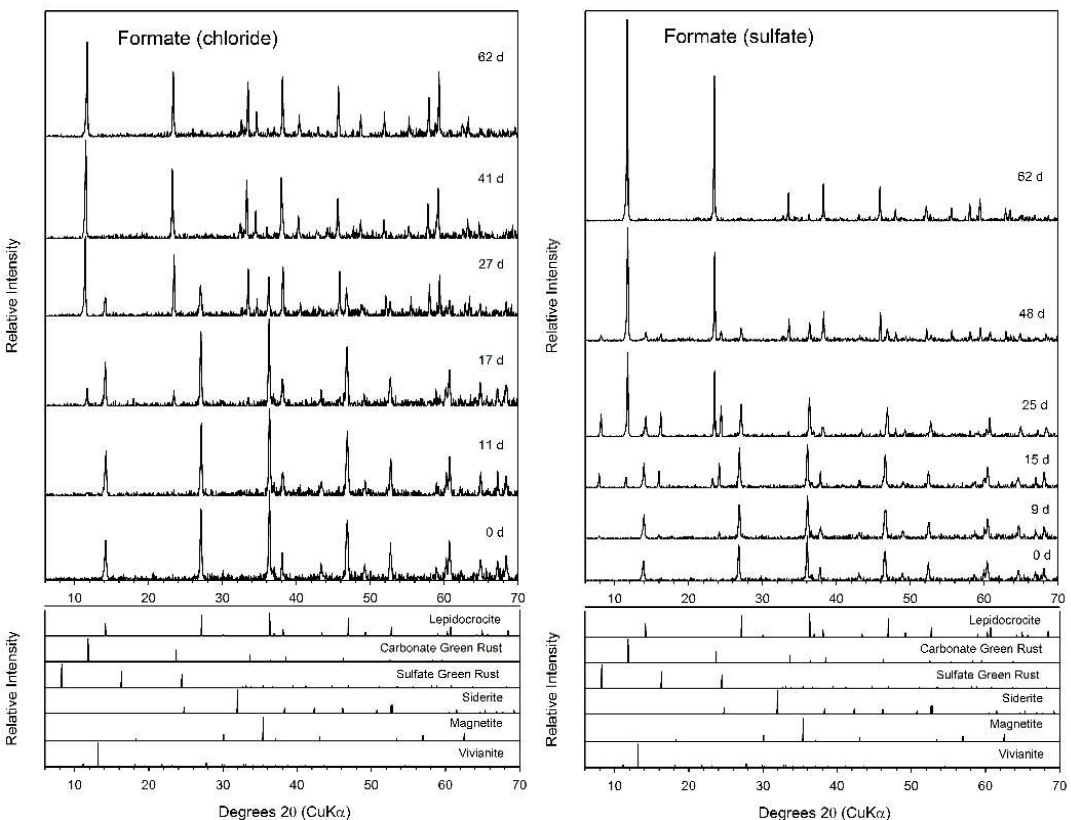
Figure 6. pXRD analysis of the solids in the systems with formate as the electron donor amended with chloride ( left ) or sulfate ( right ).